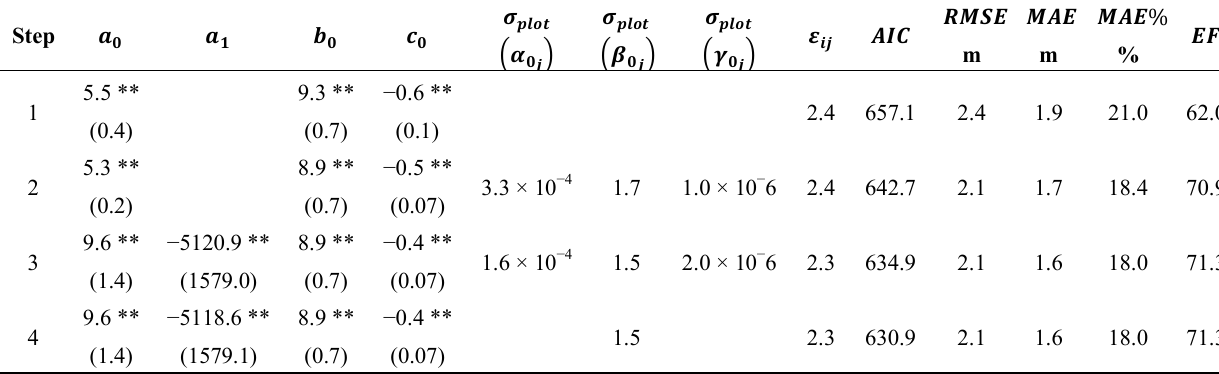
Table 4. Statistics of nonlinear mixed-effects models for SLC4F . Standard deviations are given in parentheses. Symbols and abbreviations: ( , , , ) correspond to the fixed parameters associated with variables and covariates given in Equations (5) and (6), respectively; the covariate is associated with and corresponds to the sum of annual precipitations; α , β , γ corresponds to the random plot-level parameters associated with 0 j 0 j 0 j variables given in Equation (5); ε is the residual error term; AIC: Aikake information ij criterion; RMSE: Root Mean Square Error; MAE: Mean Absolute Error;